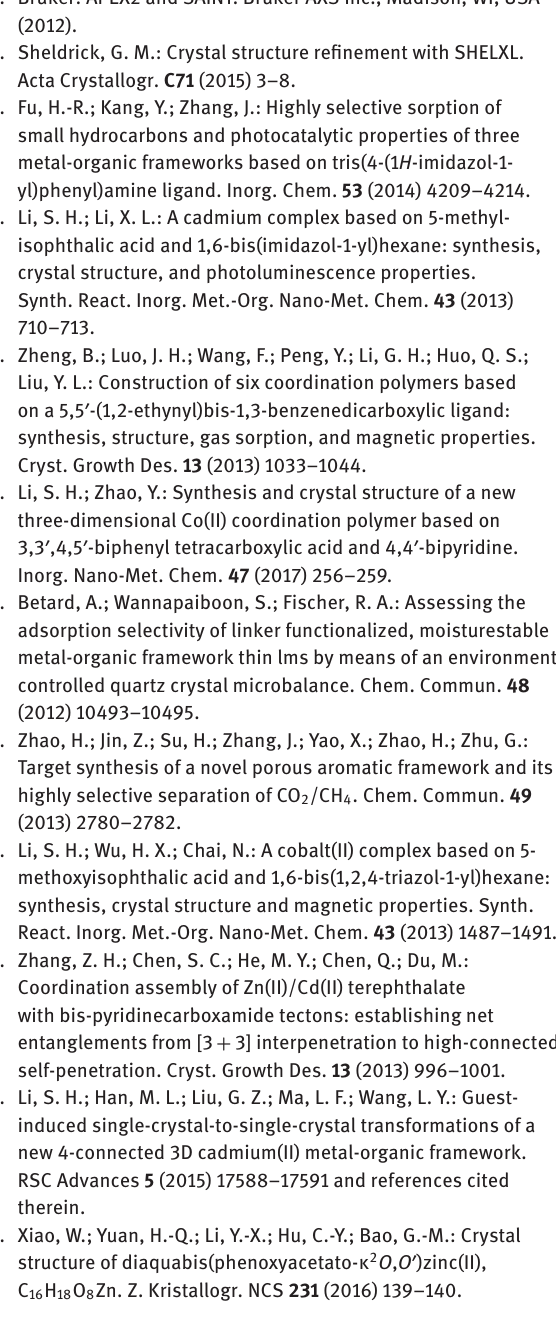
Table 2: Fractional atomic coordinates and isotropic or equivalent isotropic displacement parameters (Å 2